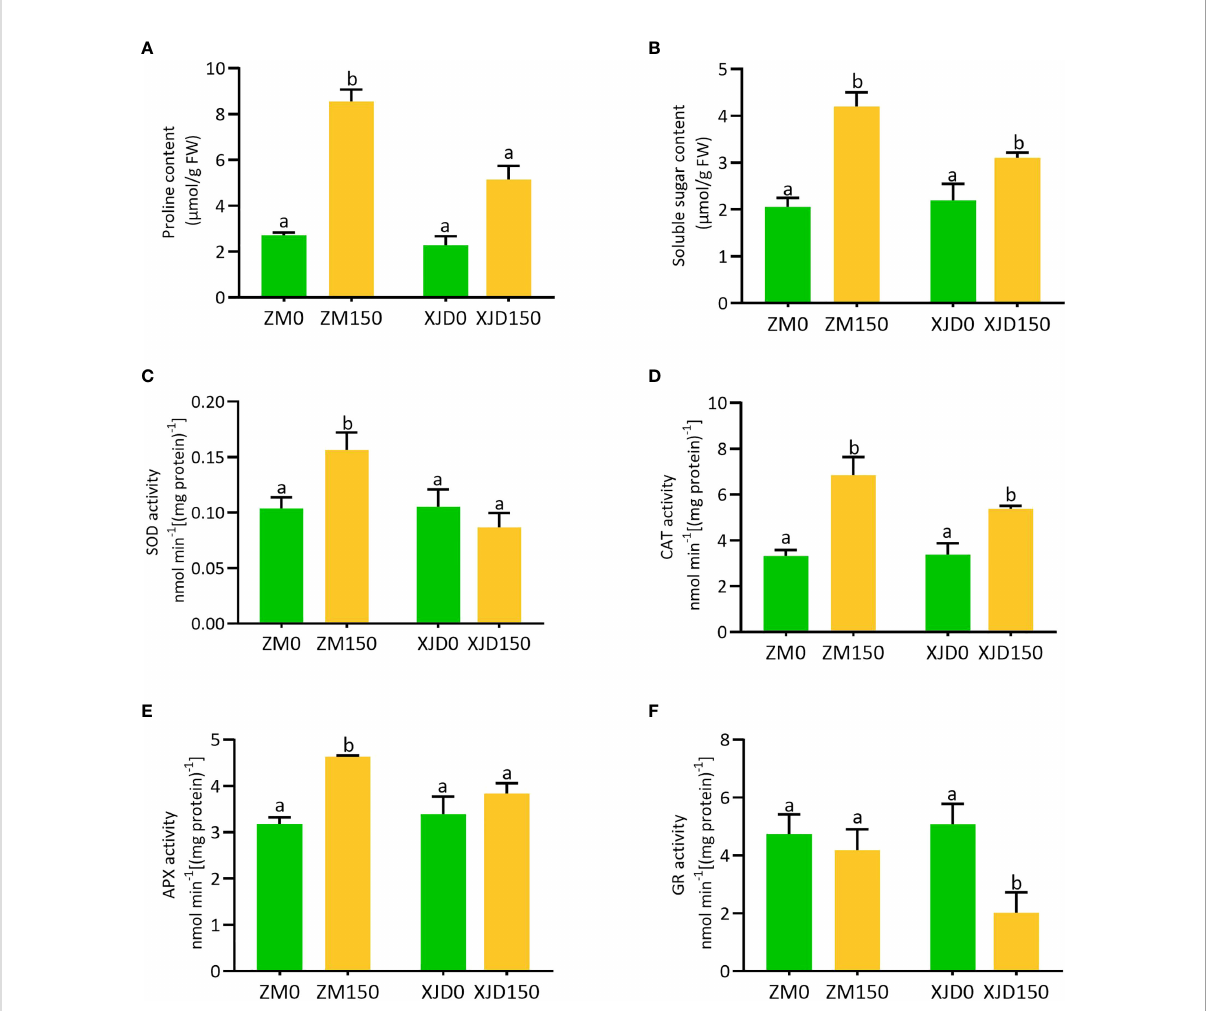
FIGURE 8 Regulation of osmolytes and antioxidant enzymes in two contrasting alfalfa under salt stress. Regulation of proline (A) , soluble sugar (B) , SOD (C) , CAT (D) , APX (E) , and GR (F) in Zhongmu (ZM) and Xingjiang Daye (XJD) under salt stress. The numeric zero (0) indicates salt-untreated (control) plant, while the numeric 150 indicates 150 mM salt treatment. Different letters above the column bar indicate signi fi cant differences among the means ± SD of treatments (n = 3). Data were analyzed by ANOVA and Tukey ’ s tests at p ≤ 0.05 signi fi cant